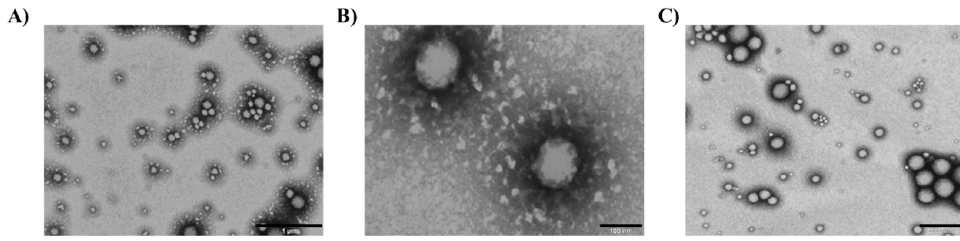
Figure 4. Transmission electron microscopical images of Lico-A NPs. ( A ) Lico-A-PLGA NPs (scale bar corresponds to 1 µm), ( B ) Lico-A PLGA-PEG-Tet-1 NPs (scale bar corresponds to 100 nm), and ( C ) Lico-A PLGA-PEG-B6 NPs (scale bar corresponds to 500 nm). 3.6. Drug Release of Licochalcone-A Functionalized Nanoparticles In order to study the release of Lico-A from Lico-A PLGA NPs, Lico-A PLGA-PEG-Tet1 NPs, and Lico-A PLGA-PEG-B6 NPs, a direct dialysis experiment was carried out. In all Lico-A NPs, an initial fast release corresponding to a burst effect of the Lico-A placed on the NPs surface followed by a sustained Lico-A release can be observed (Figure 5).